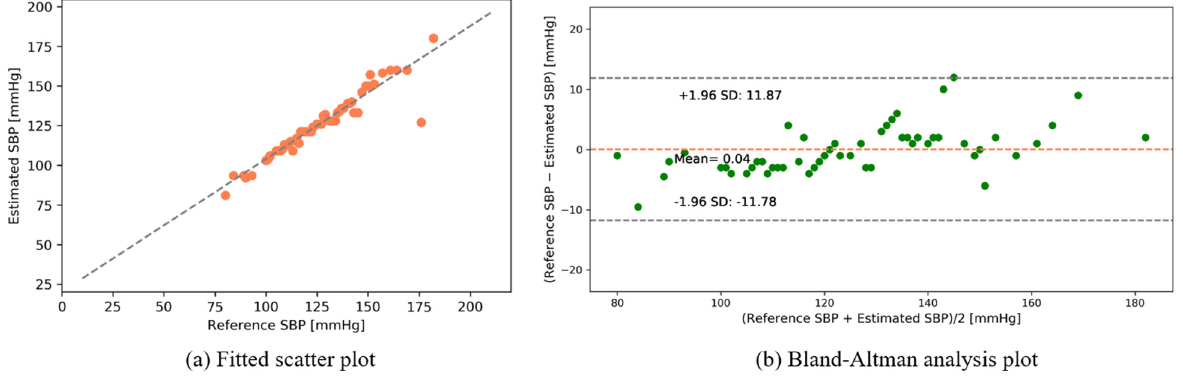
Figure 11. Fitted scatter plot of the calibration of the public dataset and MC photon intensity.